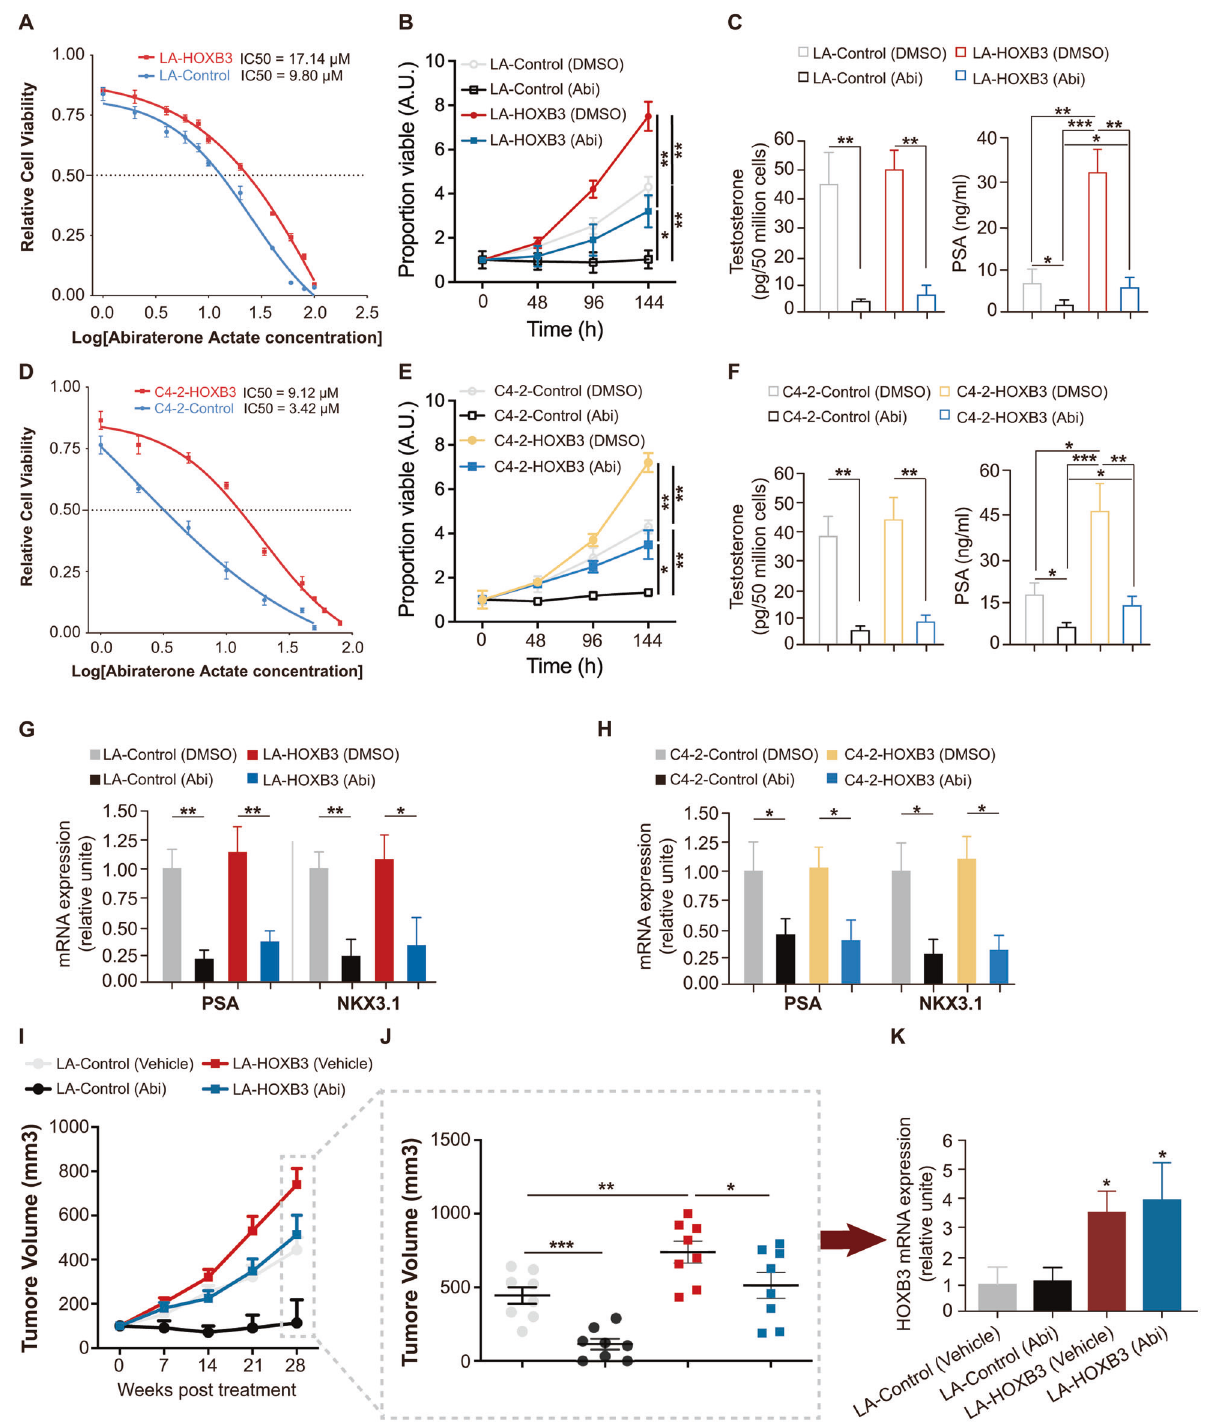
patients (Table S1). We further evaluate whether HOXB3 nuclear staining is associated with disease progression and survival in abiraterone-treated mCRPC patients. The median time to PSA progression and OS of the whole cohort was 10 months (7 months in M/H group; 13 months in N/L group) and 31 months (26 months in M/H group; unde fi ned in N/L group), respectively. We